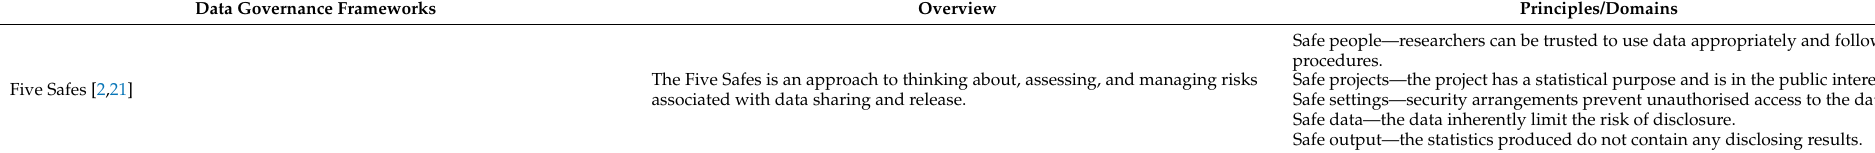
Table 2. Data governance frameworks identified in the systematic review of Indigenous Data Governance in health